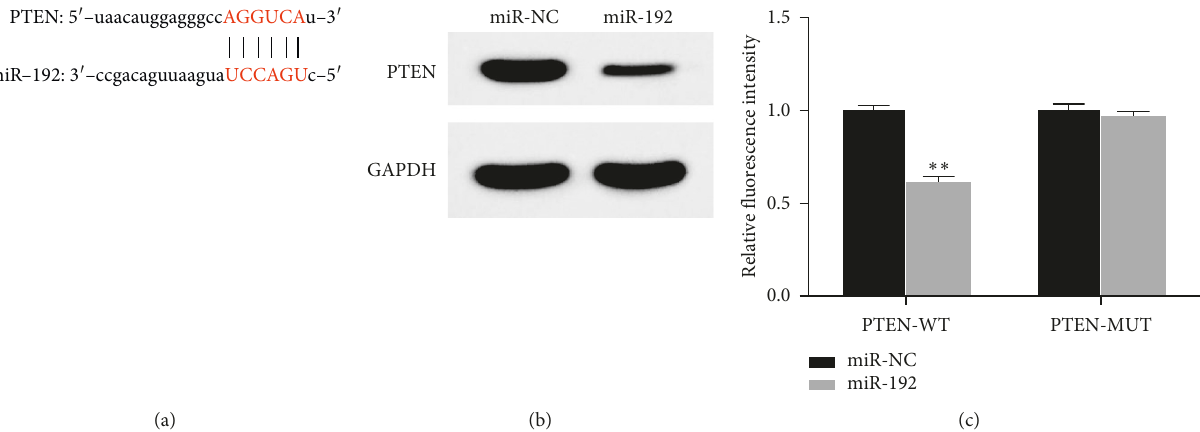
Figure 5: PTEN is the target gene of miR-192. (a) the predicted results of target genes; (b) detection of PTEN protein level by Western blotting; (c) detection of the Interaction between miR-192 and PTEN by DLRTM.